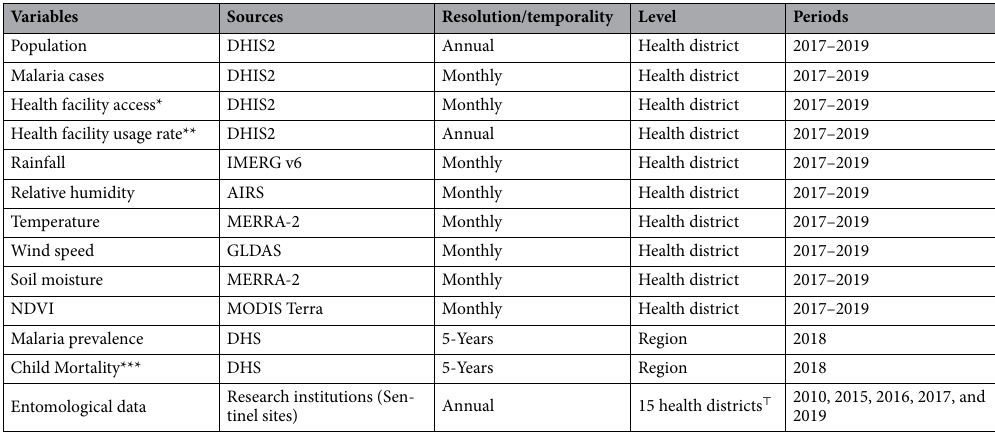
Table 1. Data assembly. NDVI normalized difference vegetation index, DHIS2 district health information software 2, IMERG integrated multisatellite retrievals for GPM, AIRS atmospheric infrared sounder, MERRA- 2 modern-era retrospective analysis for research and applications, version 2, MODIS moderate resolution imaging spectroradiometer, GLDAS global land data assimilation system, DHS demographic and health